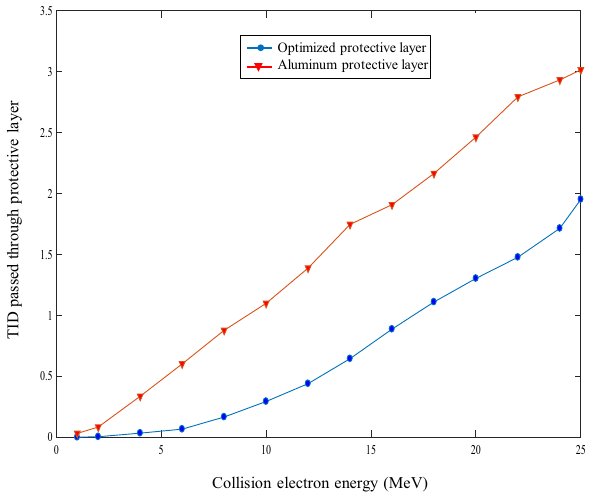
Figure 4. Curve of total ionizing dose passing through optimal shield and a 2 mm aluminum shield in different energies (the blue curve is related to a three-layer shield).